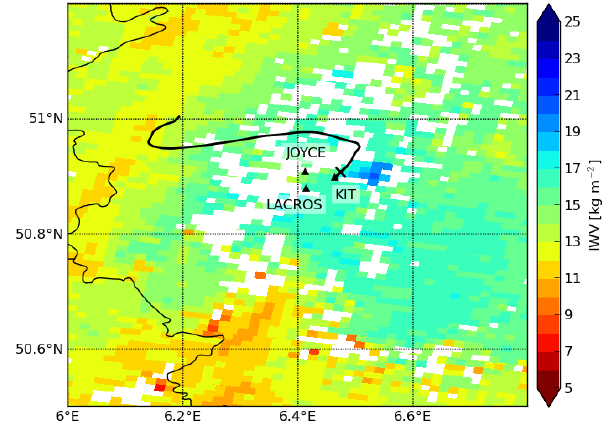
Figure 3. MODIS-NIR IWV for 5 May 2013 at 10:25UTC. Cloudy pixels are displayed in white. The black line indicates the track of the radiosonde launched at 11:00UTC with a cross at the location where it leaves the planetary boundary layer.